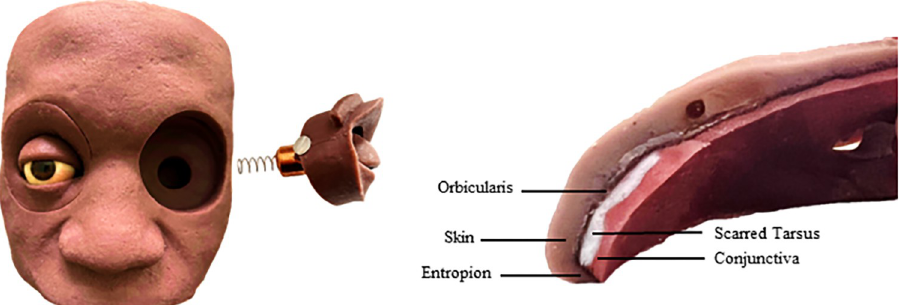
Fig 1. HEAD START Surgical Simulator base with removable orbits (left) and eyelid cartridge cross-section showing entropic eyelid margin and layers of eyelid (right).